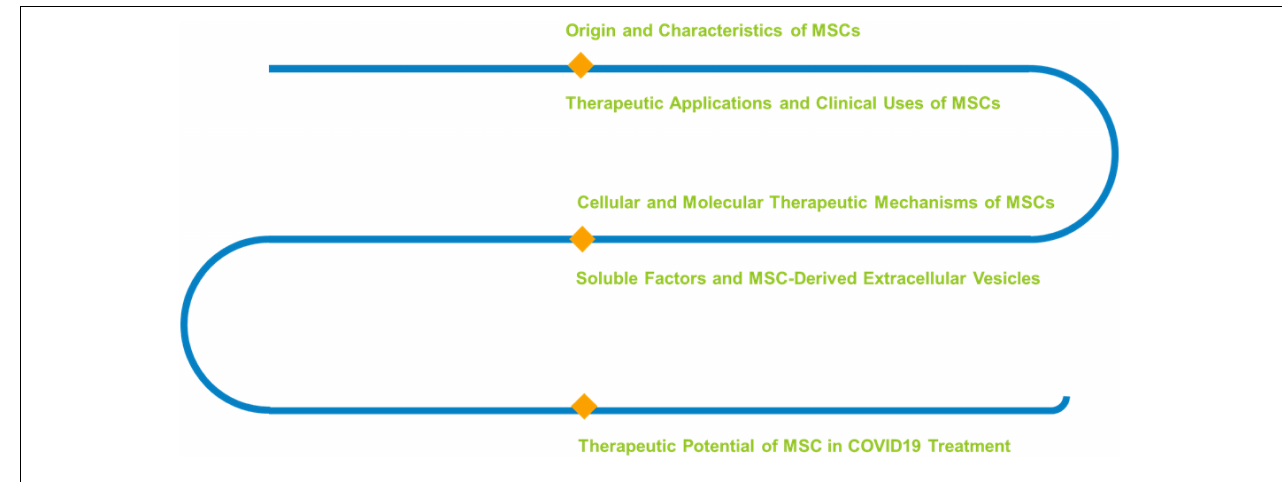
FIGURE 1 | MSCs are isolated from several sources (neonatal, fetal, and adult tissues) and can “in theory” differentiate into different types of cells.